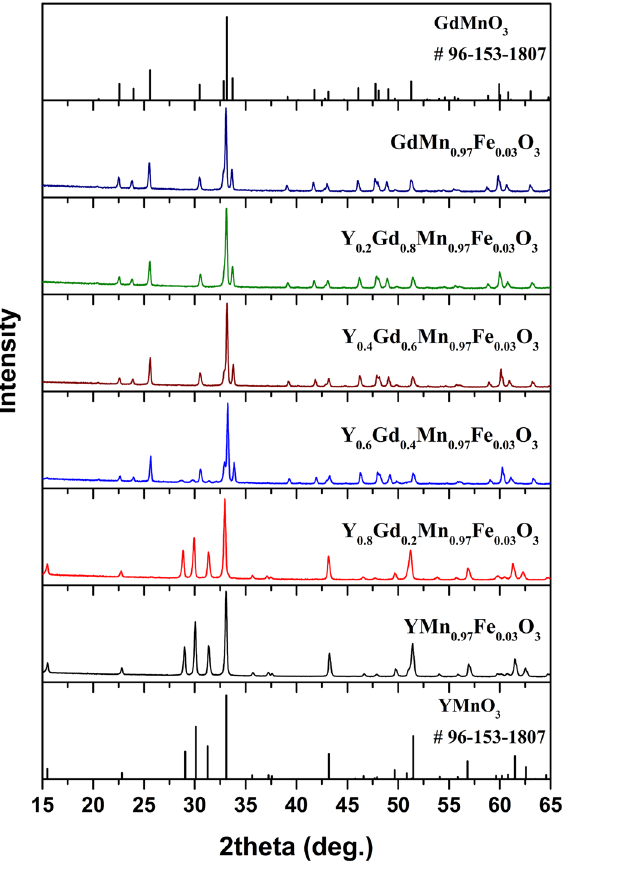
Figure 1. XRD patterns of Y x Gd 1−x Mn 0.97 Fe 0.03 O 3